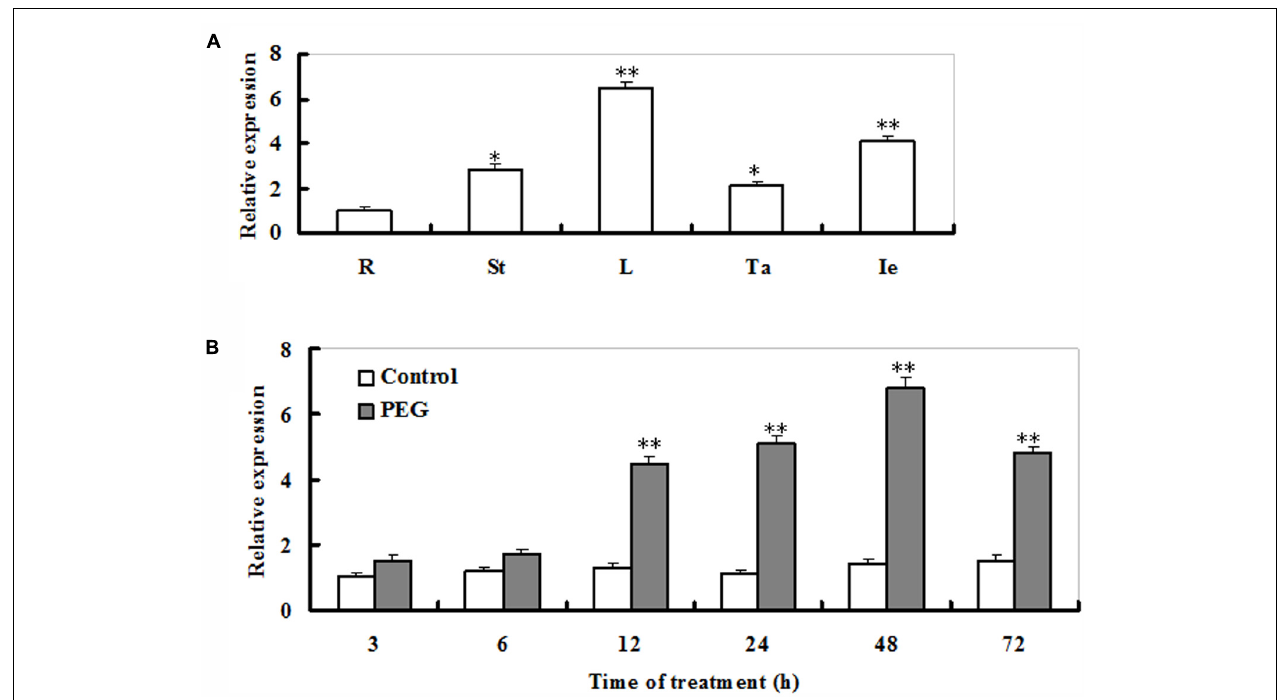
FIGURE 1 | Transcript profiles of ZmSO in major organs of maize adult plants and its response to drought stress. (A) The transcriptional patterns of ZmSO in maize root (R), stem (St), leaf (L), tassel (Ta), and immature ear (Ie) samples evaluated by real-time qPCR. For each qPCR, the transcript levels of maize reference gene Ubiquitin were also evaluated in various samples. For each assay, the expression level in roots was defined as 1.0 and three technical replicates were conducted. Data shown are Mean ± SE of three independent experiments. ∗∗ t -test, with P < 0.01; ∗ t -test, with P < 0.05. (B) Time-course analysis of ZmSO transcript levels under PEG-induced water stress by real-time qPCR. Two-week-old maize seedlings were exposed to distilled-water (Control) or 15% PEG8000 (PEG) for indicated time points (3, 6, 12, 24, 48, and 72 h), and leaf samples were used for qPCR analysis. For each qPCR, the transcript levels of maize reference gene Ubiquitin were also evaluated in various samples. For each experiment, three technical replicates were conducted. Data shown are Mean ± SE of three independent experiments. ∗∗ t -test, with P <